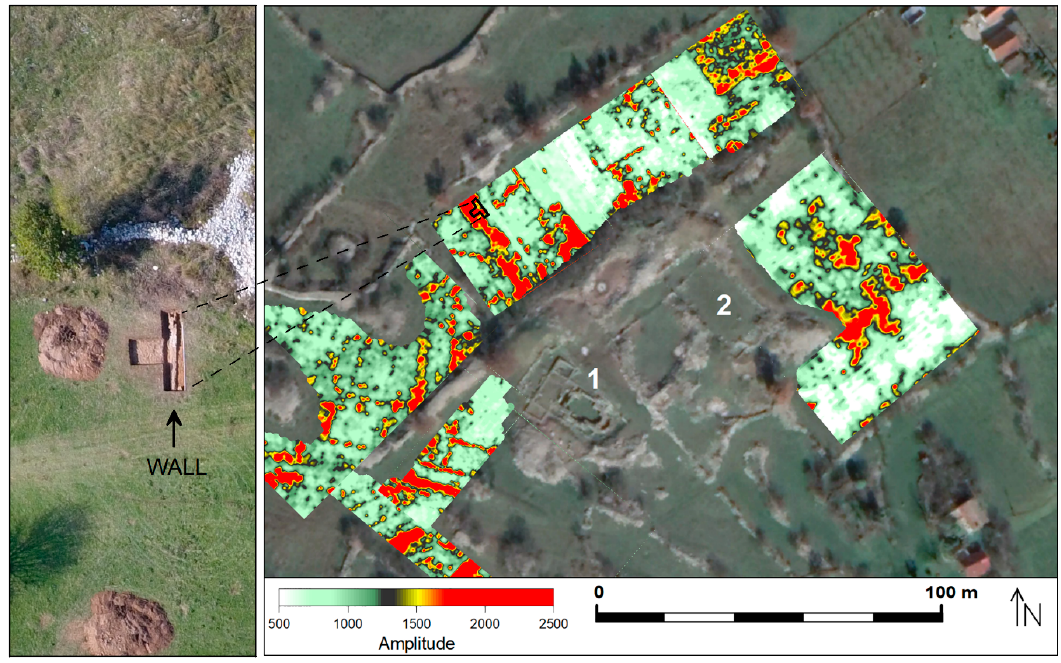
Figure 11. Dolcea: GPR time slice relative to 14–18 ns around the medieval churches 1 and 2 ( right ) and a picture of an excavated wall after geophysical prospections ( left ).